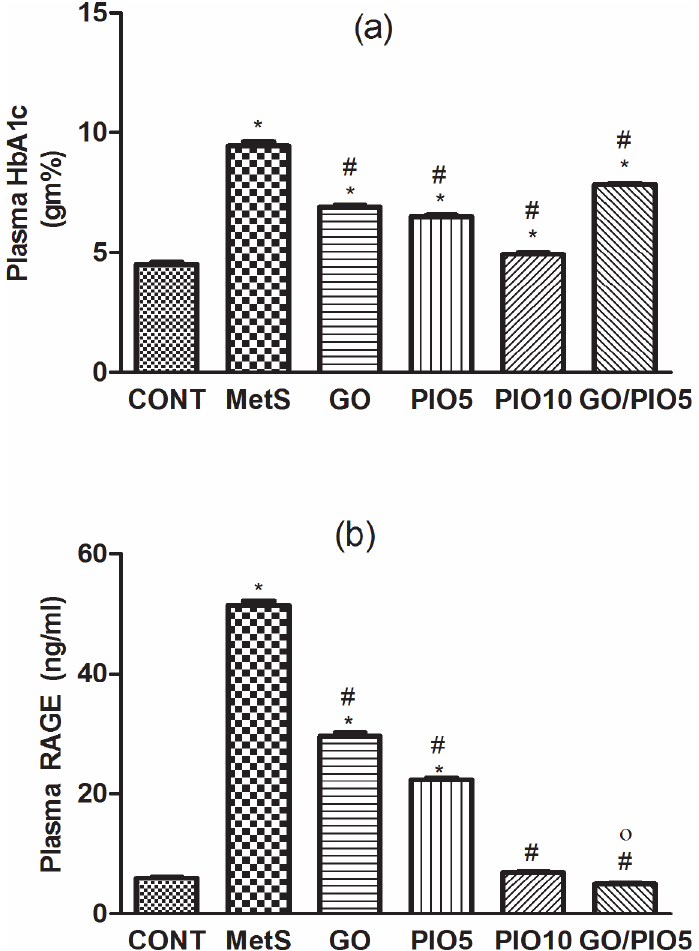
Fig 2. Effect of 4 weeks daily oral administration of geraniol (GO; 250 mg/kg), pioglitazone (PIO; 5 and10 mg/kg), and GO with PIO5 on plasma (a) glycated haemoglobin (HbA1c) and (b) receptor for advanced glycated end product (RAGE) in fructose-induced metabolic syndrome (MetS) in rats. Values are mean (6 – 8 animals) ± SEM. P < 0.05, as compared to control (CONT) ( * ) and MetS ( # ) groups using one-way ANOVA followed by Tukey – Kramer test. Significant potentiative and synergistic interactions ( o ) when GO and PIO5 were combined using the factorial design test.